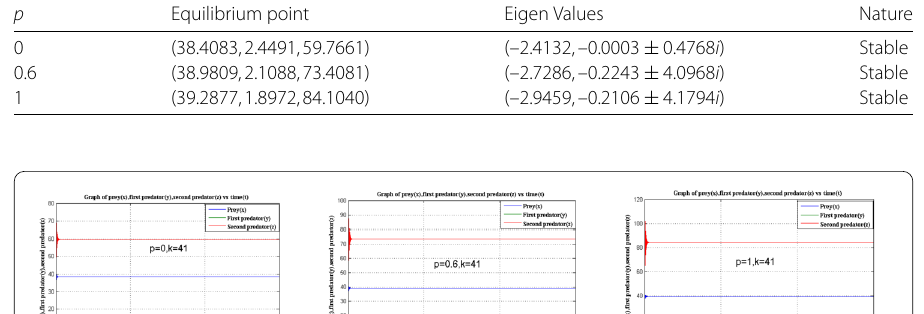
Table 8 The nature of the interior equilibrium point for different values of the parameter p p